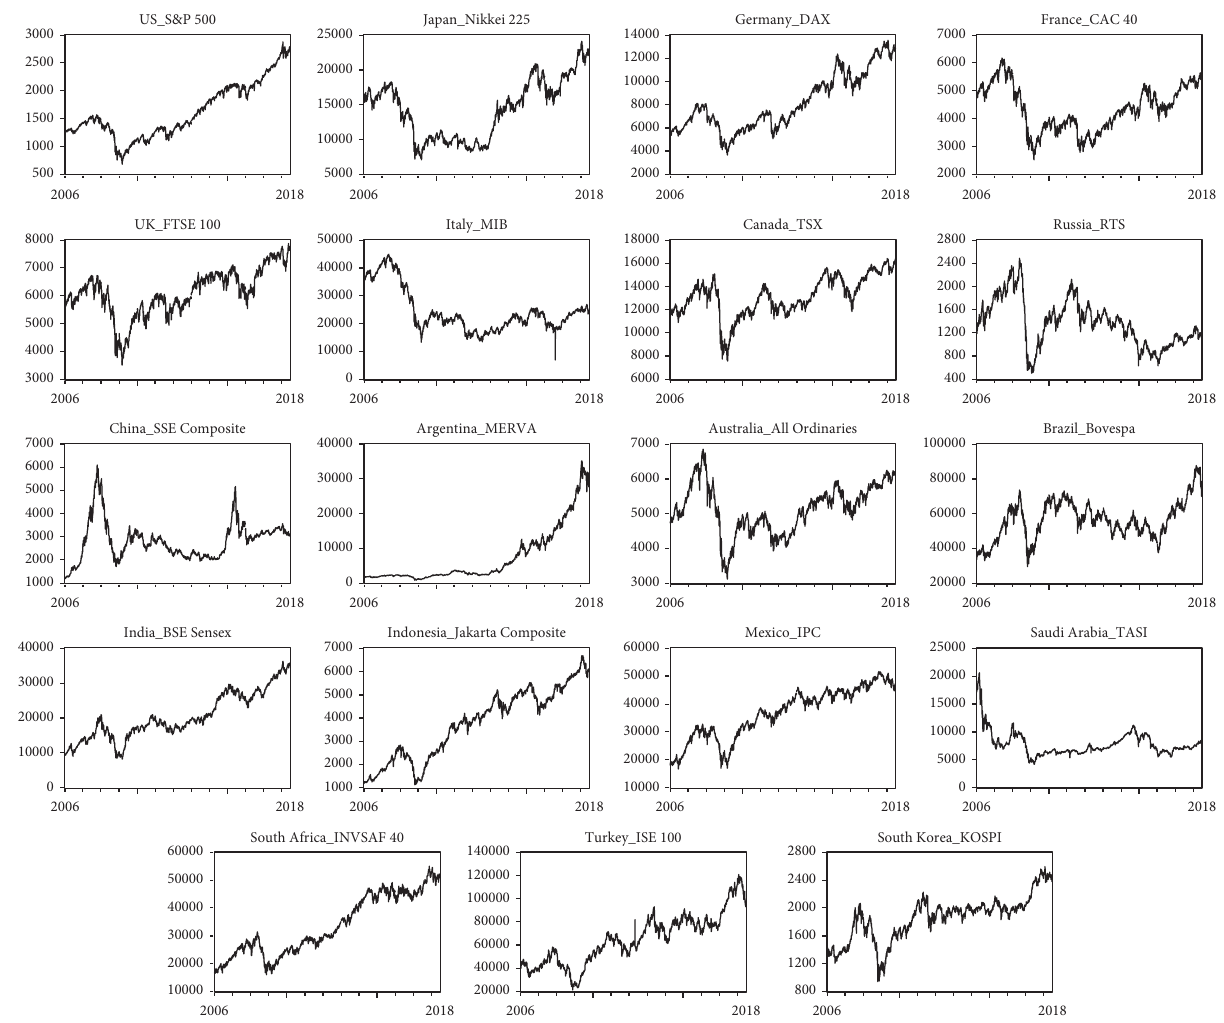
Figure 2: The volatility characteristics of G20 stock prices. (a) US_S&P 500, (b) Japan_Nikkei 225, (c) Germany_DAX, (d) France_CAC 40, (e) UK_FTSE100,(f)Italy_MIB,(g)Canada_TSX,(h)Russia_RTS,(i)China_SSEComposite,(j)Argentina_MERVAL,(k)Australia_AllOrdinaries,(l) Brazil_Bovespa,(m)India_BSESensex,(n)Indonesia_JakartaComposite,(o)Mexico_IPC,(p)SaudiArabia_TASI,(q)SouthAfrica_INVSAF40,(r) Turkey_ISE 100, and (s) South